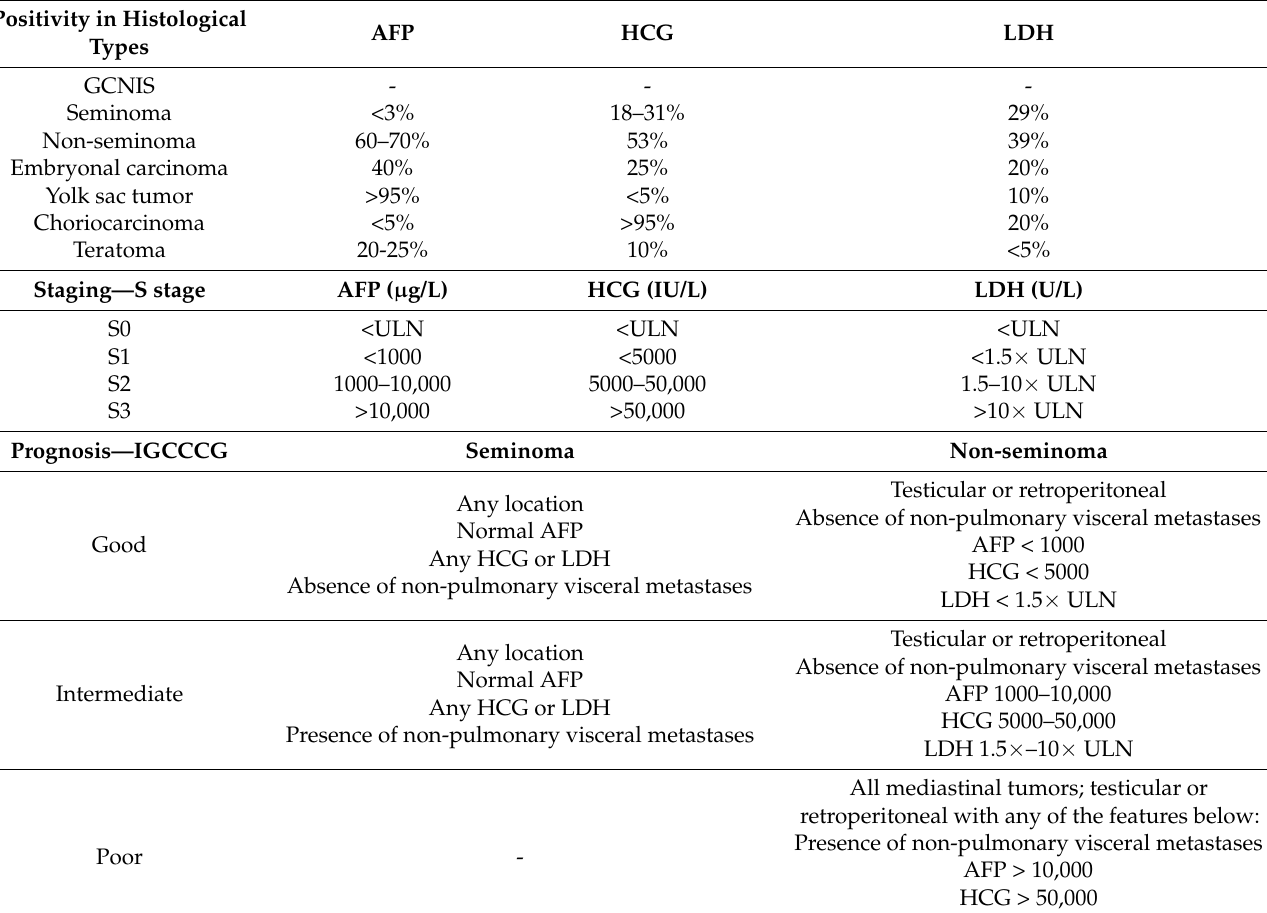
Table 1. Classical serum tumor markers and their utility in testicular germ cell